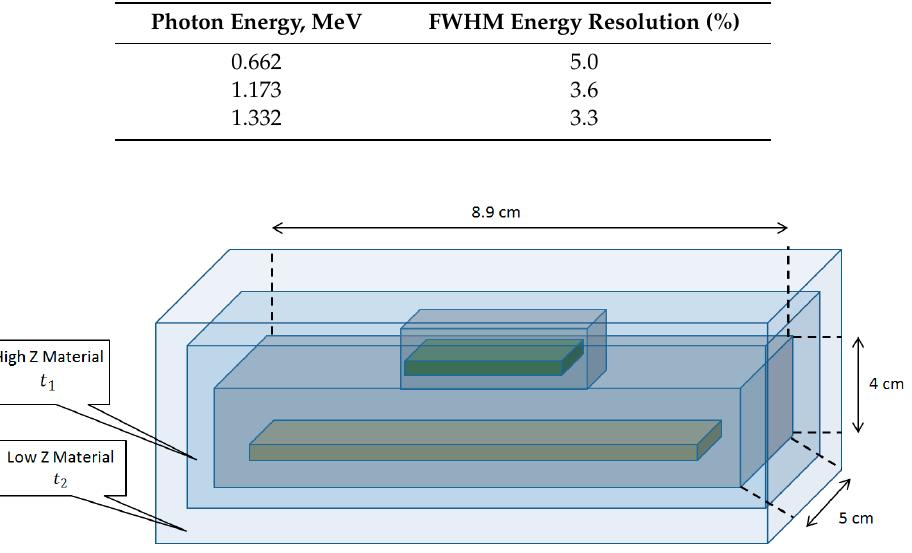
Figure 10. Shielding of the Pixhawk UAS controller. Table 2. Radiation damage due to neutron irradiation of the controller.